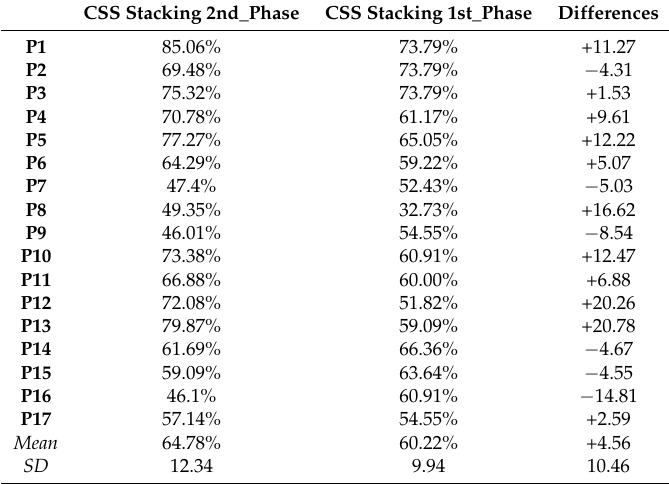
Table 8. Second phase. Accuracy percentages per actor for the CSS stacking classifier systems of the second phase (CSS stacking 2nd_Phase) and the comparison with the CSS stacking classifiers of the first phase (CSS stacking 1st_Phase). Mean and SD rows denote the average and standard deviation for each classifier for all of the